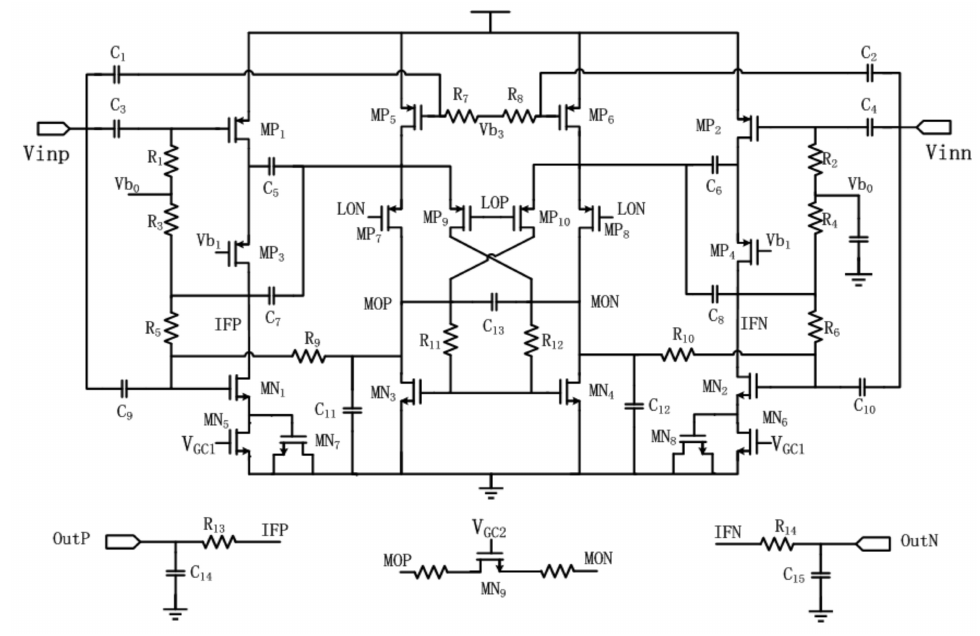
Figure 3. The circuit schematic of the proposed function-reused